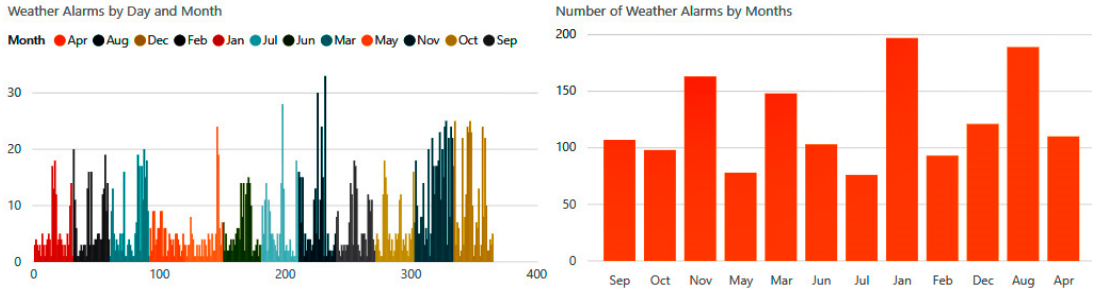
Figure 23. Number of alarms during extreme weather. Table 13. Activities alarms and constraints for a specific profile. Data